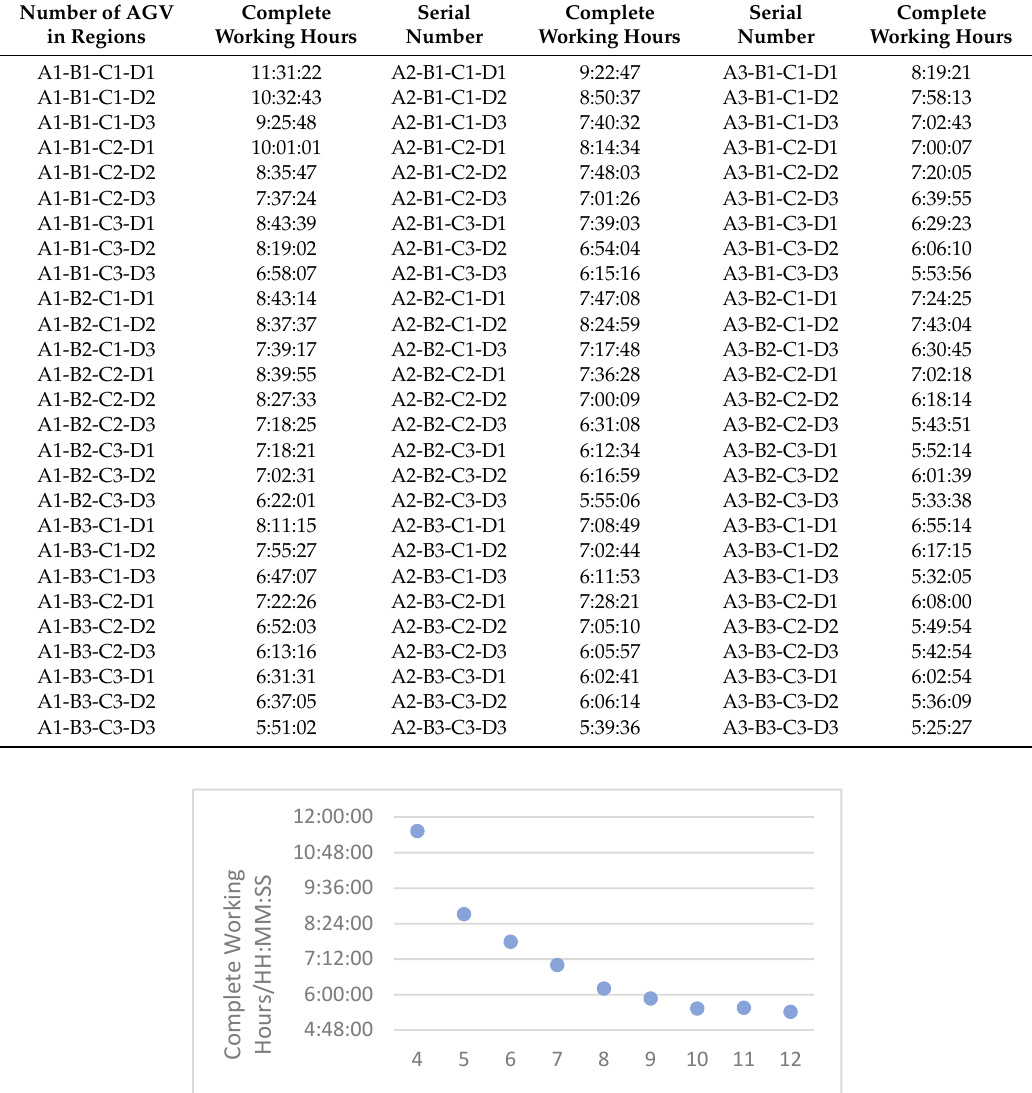
Table 10. Shared resource pool simulation results across regions.